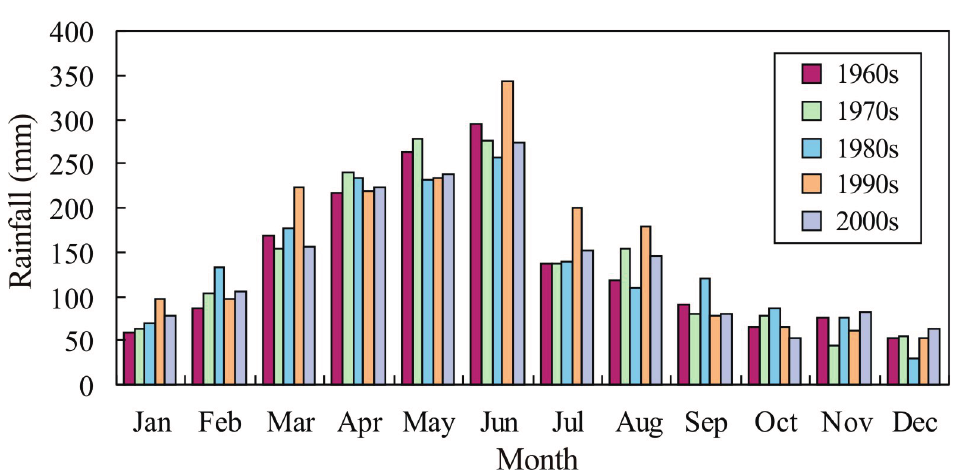
Figure 2. Variation of monthly precipitation in different